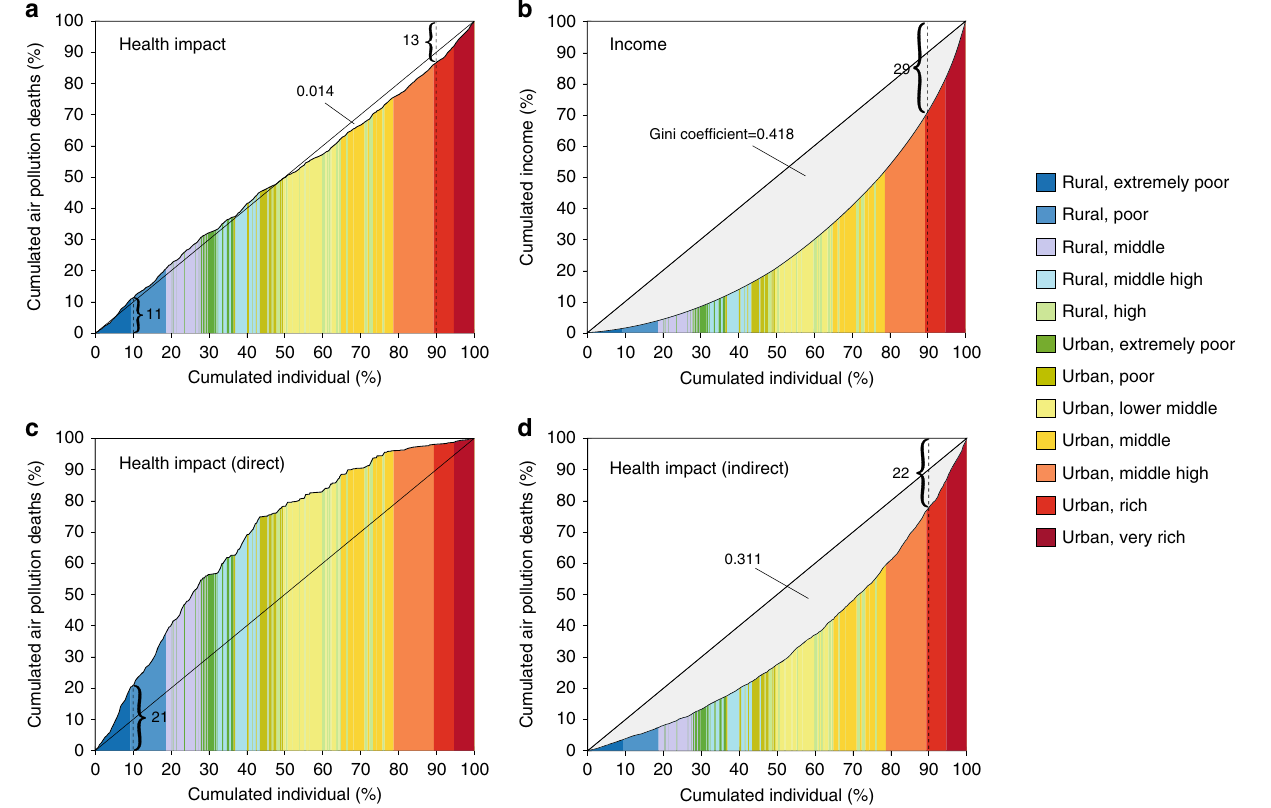
Fig. 3 Lorenz curves for air pollution-related deaths attributable to consumption and income earned for households. a Lorenz curve for premature deaths related to household consumption emissions. b Lorenz curve for household income earned. c Lorenz curve for premature deaths related to household direct emissions. c Lorenz curve for premature deaths related to household indirect emissions. Household groups are sorted by income per capita ordered from the poorest on the left to the richest on the right, and the horizontal axis in panel ( a – d ) show the cumulative population share. The diagonal is the line of perfect equality. Source data are provided as a Source Data fi